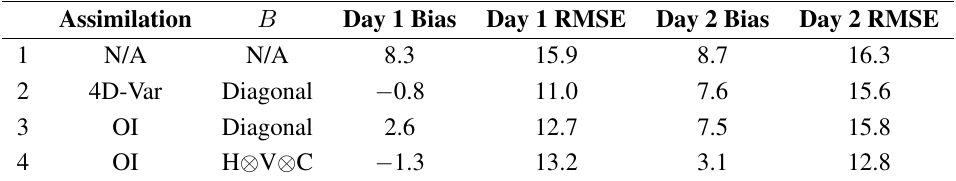
Model ozone biases and root-mean-square errors (RMSE) against AIRNow observations during 8:00 am–8:00 pm local time on Day 1 (August 5, 2007) and Day